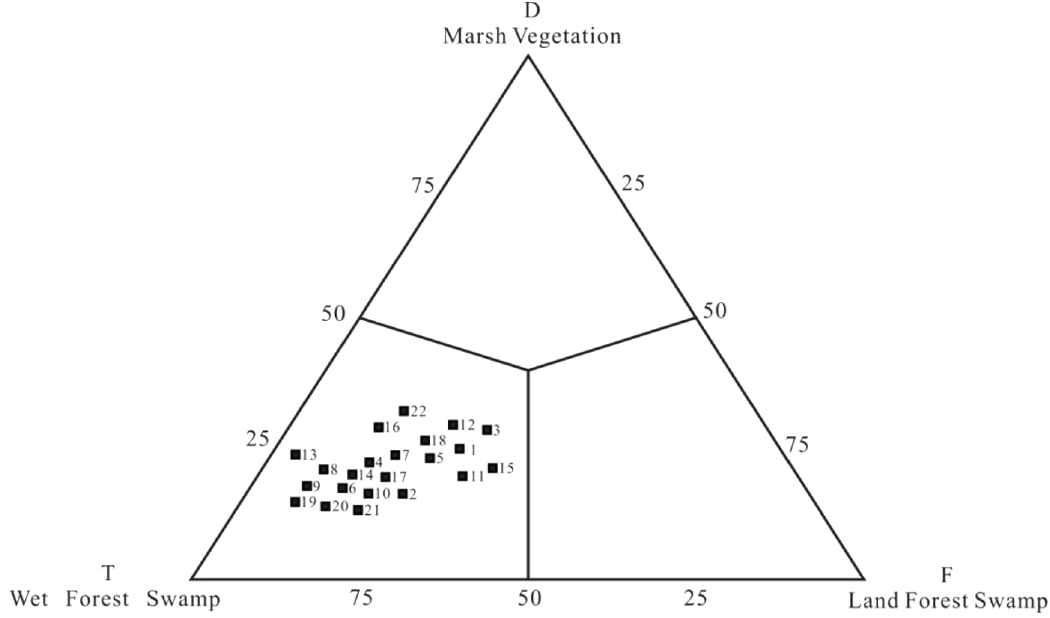
Fig. 7 Triangular chart of Coal-forming swamp in Hanshuiquan district, Santanghu Coalfield, NW China. Modified by Mukhopadhyay